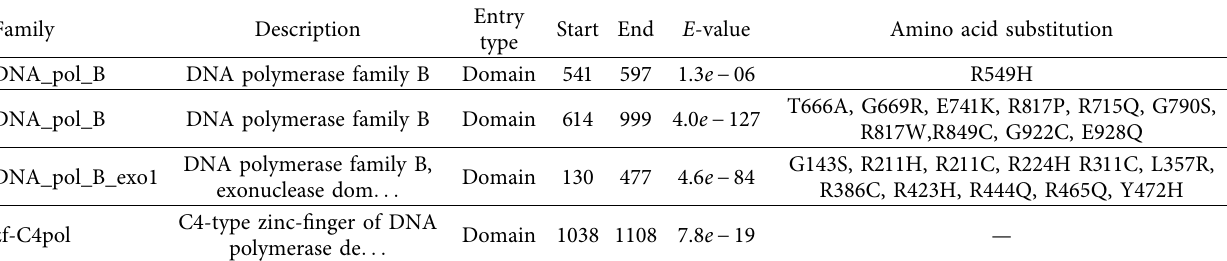
Table 2: Association of deleterious SNPs with domain